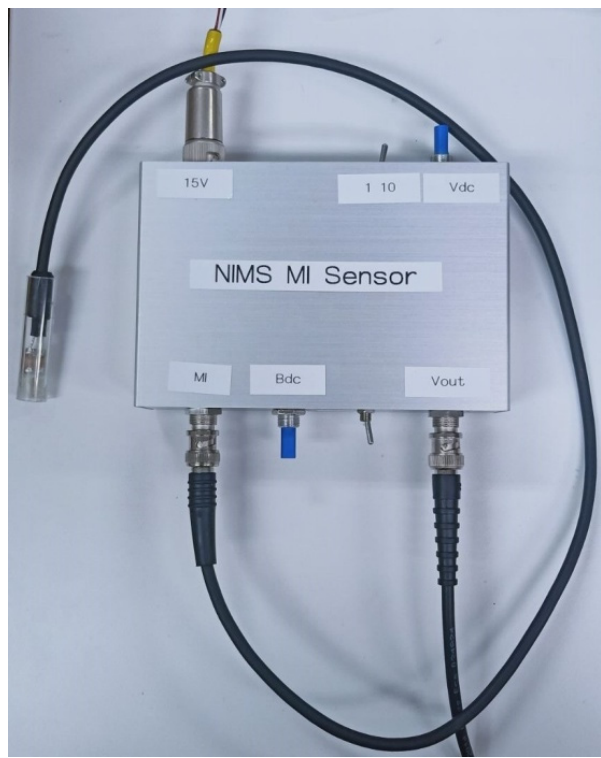
Figure 8. FeCoSiB amorphous wire magnetic sensor and the driving circuit.